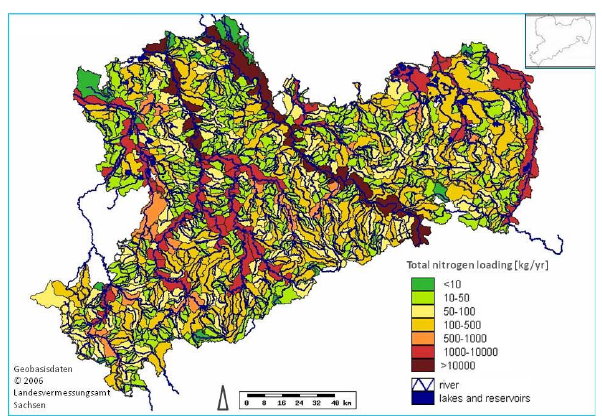
Fig. 2. Total nitrogen loading per surface water body including retention in rivers/streams and reservoirs.